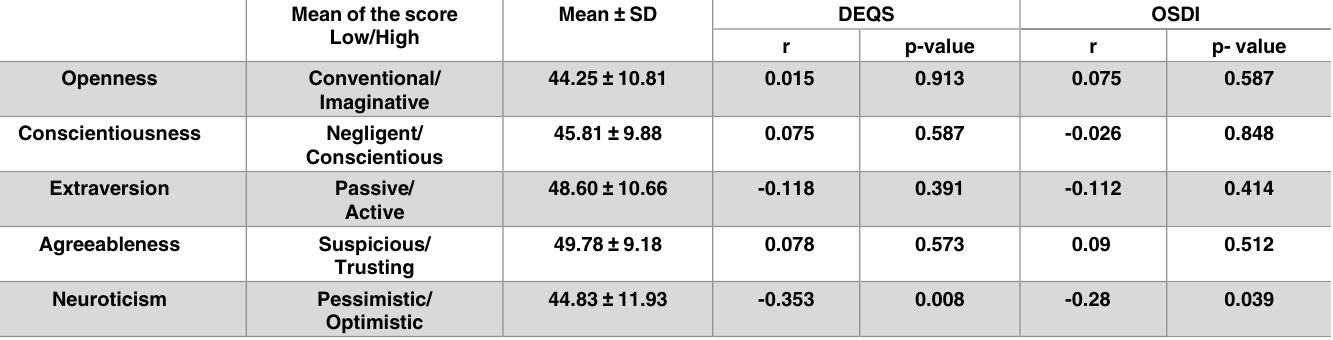
Table 2. The Big Five personality traits and symptom scores (DEQS and OSDI). Mean of the score